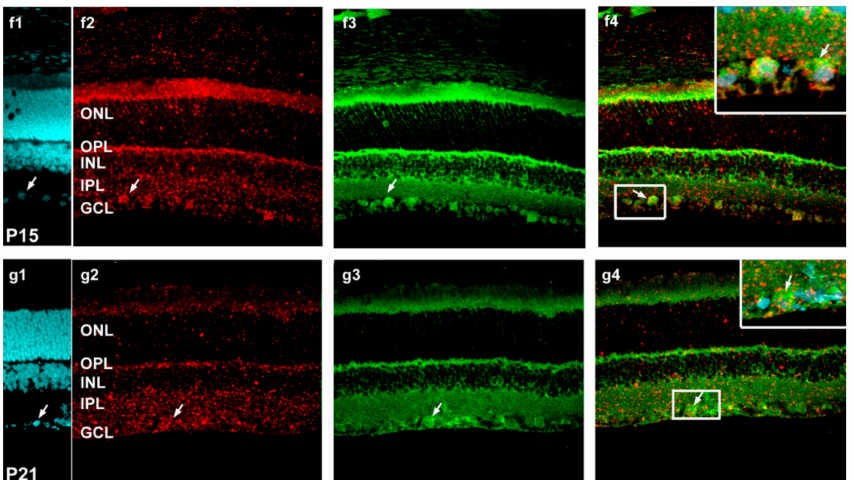
Figure 7. Characterization of miR-9-expressing (red: TSA Cy3) cells (in situ hybridization) and OneCut2 (green: Alexa Fluor-488) by immunolabeling in postnatal developing retina sections at the indicated ages (( a 1– a 4) P1; ( b 1– b 4) P3; ( c 1– c 4) P5; ( d 1– d 4 P7; ( e 1– e 4) P10; ( f 1– f 4) P15; ( g 1– g 4) P21). The first column demonstrates the DAPI staining, the second column shows mir-9 and the third column represents OneCut2 staining. The fourth column demonstrates the merged images of ISH–IHC staining. Arrows indicate ganglion cells, and horizontal cells are demonstrated by double arrowheads. Scale bar, 50 µ m in Panel a2. NBL, neuroblast layer; GCL, ganglion cell layer; IPL, inner plexiform layer; INL, inner nuclear layer; OPL, outer plexiform layer; ONL, outer nuclear layer.